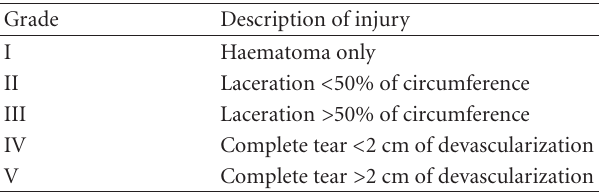
Table 1: AAST organ injury severity scale for the ureter